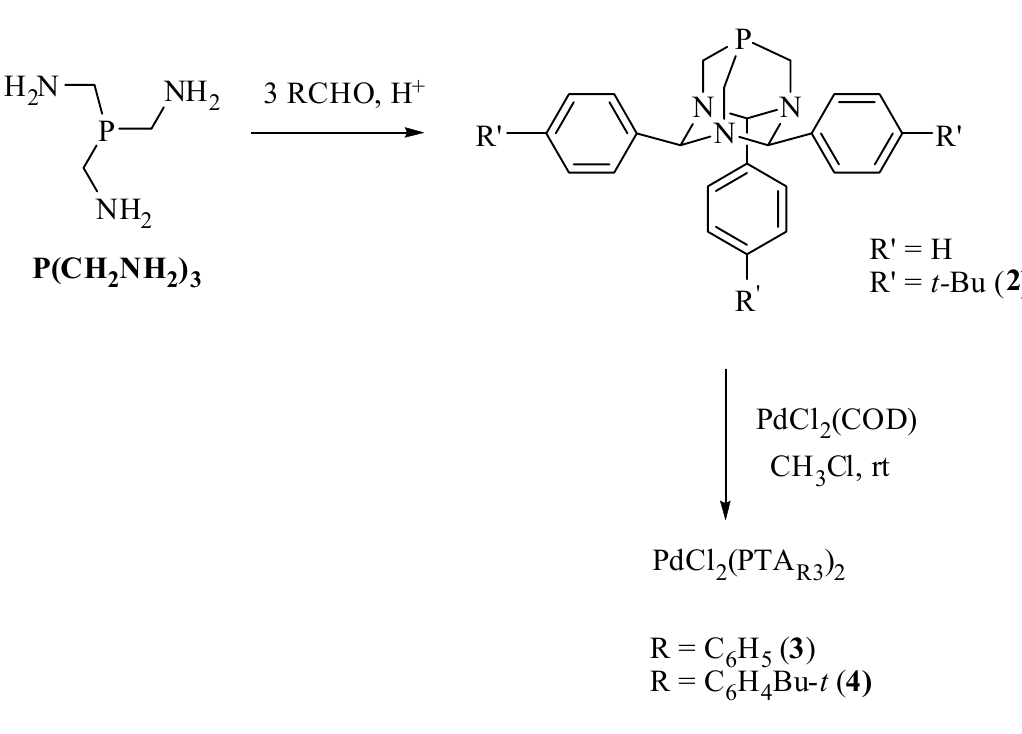
Figure 3. Thermal ellipsoid plot (50% probability) of 2 . Hydrogen atoms have been omitted for clarity. Selected bond lengths (Å) and angles (deg.): P1-C N-C = 1.481(4), C4-C7 = 1.516(5), C5-C17 = 1.520(5), C6-C27 = 1.515(5), C-P1-C ave